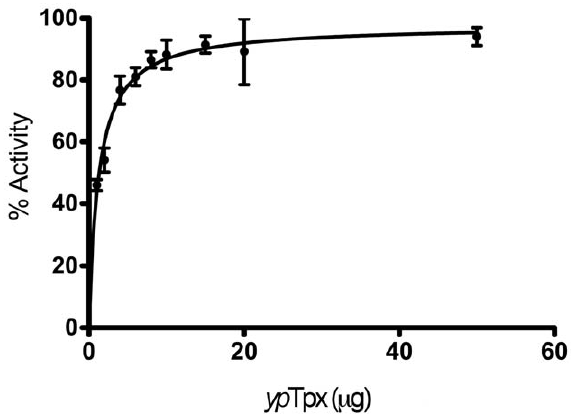
Figure 2. Glutamine synthetase assay. The activity of yp Tpx is confirmed by its ability to rescue the activity of glutamine syntethase (to 90% of original activity at 15 m g yp Tpx).